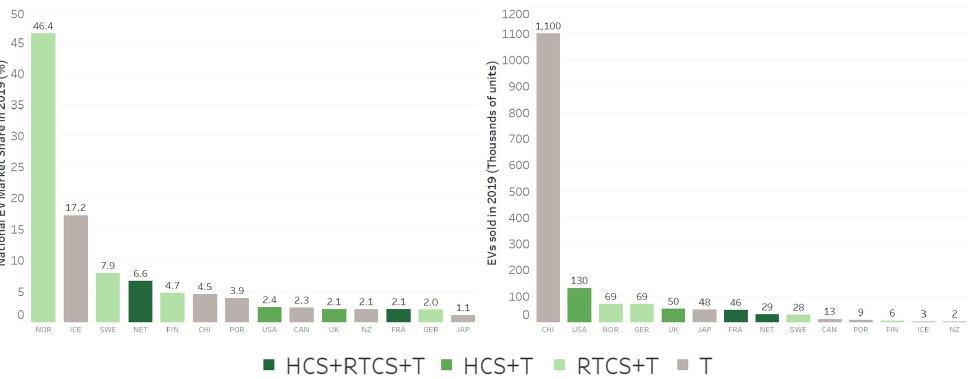
Figure 2. For each of the 14 countries in scope, the national EV market share [57] and the estimated number of EVs sold [121] is shown: HCS refers to historical charging session data, RTCS refers to real-time charging session data and T refers to traffic counts and/or travel survey